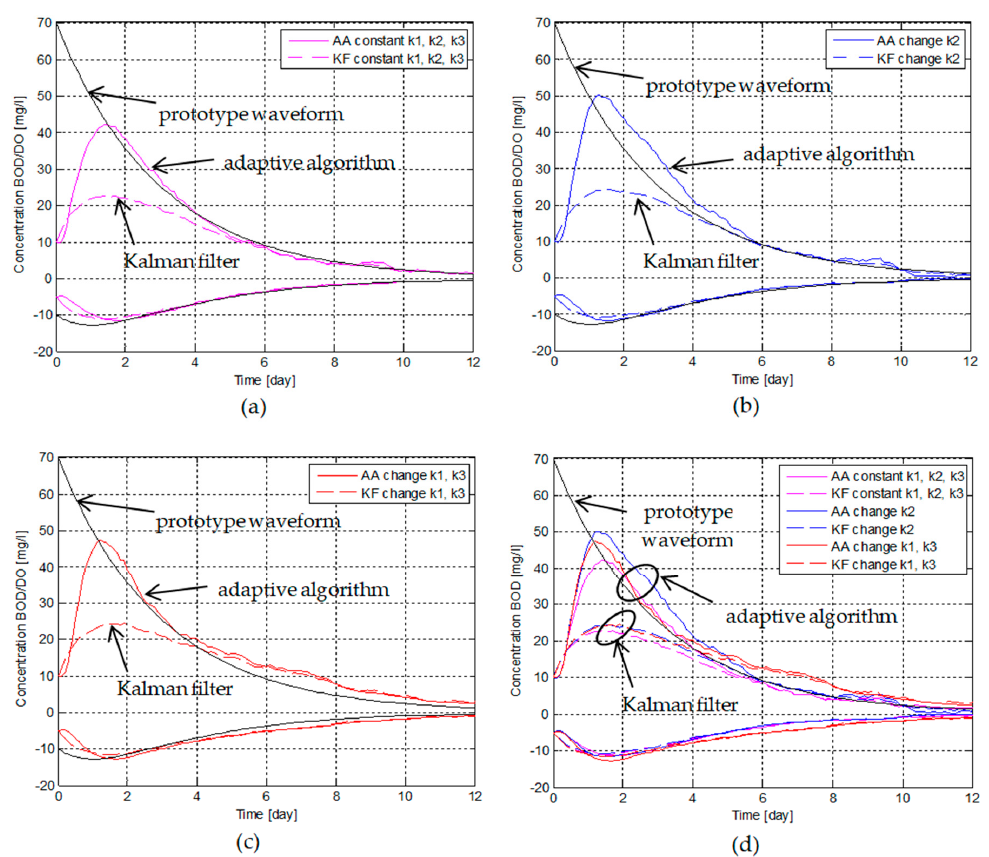
Figure 4. Distributions of generated signals for di ff erent parameters of the model: ( a ) k 1 , k 2 , k 3 identical for algorithms and model, ( b ) k 2 di ff erent for algorithms and model, ( c ) k 1 , k 3 di ff erent for algorithms and model, ( d ) comparison of all